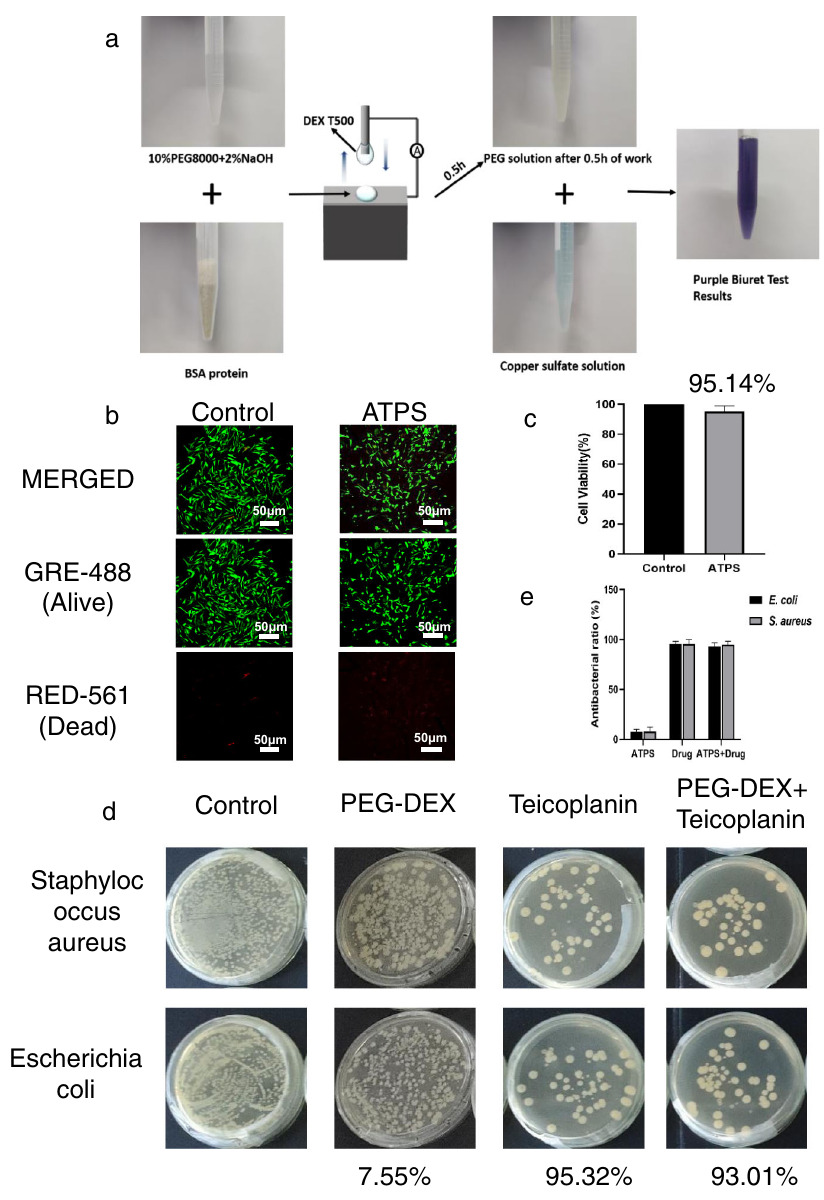
Fig.7|SuperiorbiocompatibilityoftheL-LTENGasthemicroreactoranddrug carrier. a PEG droplet with BSA protein added to the 1% CuSO 4 ·5H 2 O solution before and after the L-L TENG operated for 0.5h. b Live/dead cell fl uorescence